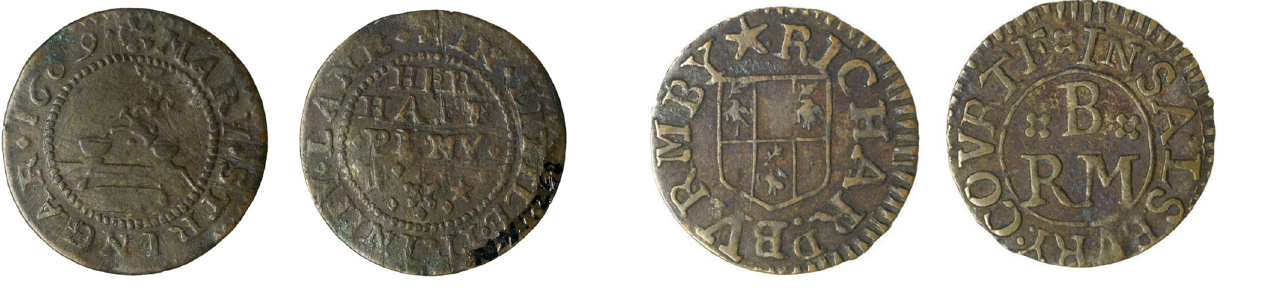
Fig. 5 Trade token issued by Mary Stringar, London 1669. This fi gure is Fig. 6 Trade token issued by Richard Burmby, London year unknown (1649 – 1672). This fi gure is not covered by the Creative